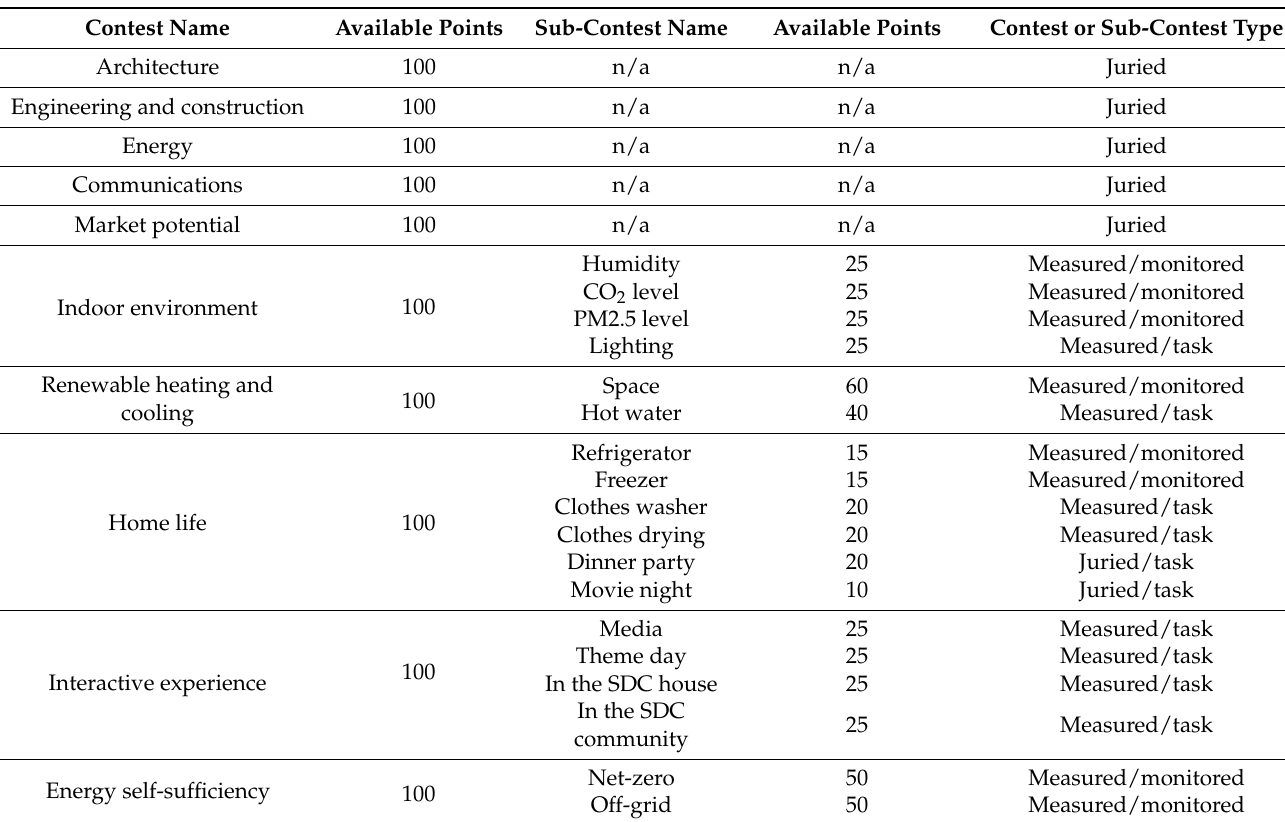
Table 2. The Third SDC